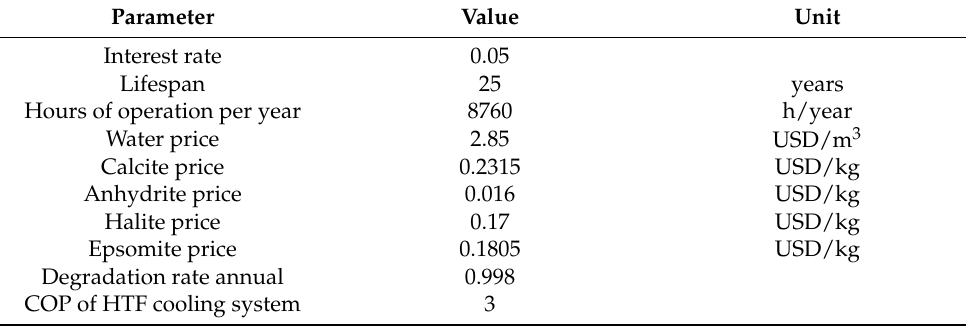
Table 6. Economic